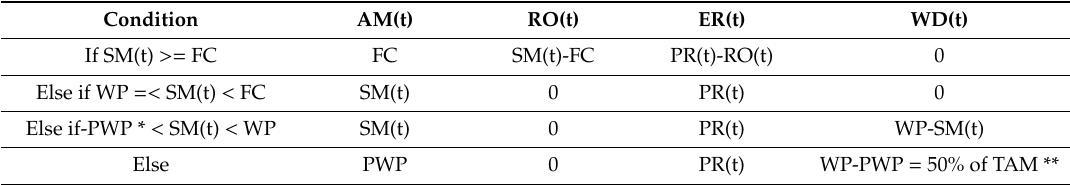
Table 1. Calculation of soil moisture (SM(t)).